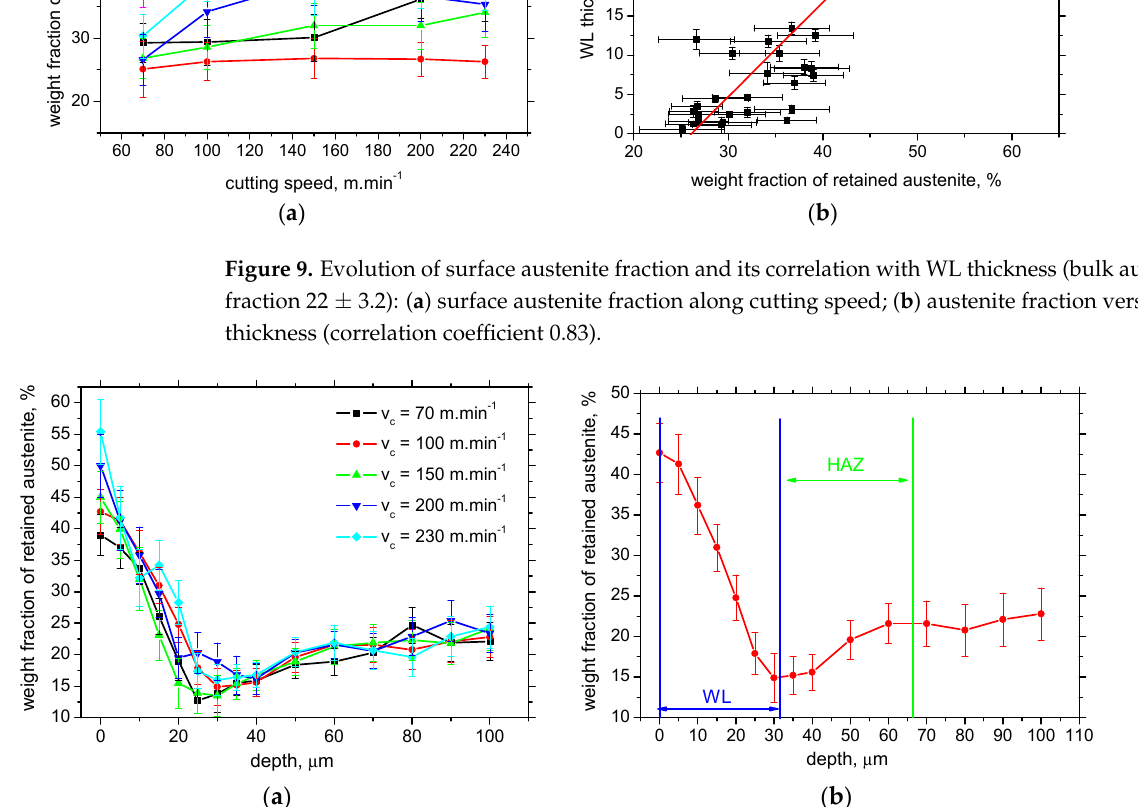
Figure 10. Depth profiles of austenite fraction for VB = 0.8 mm and detail of austenite fraction for cutting speed 100 m.min − 1 : ( a ) depth profiles for VB = 0.8 mm; ( b ) detail of austenite fraction for cutting speed 100 m.min − 1 .